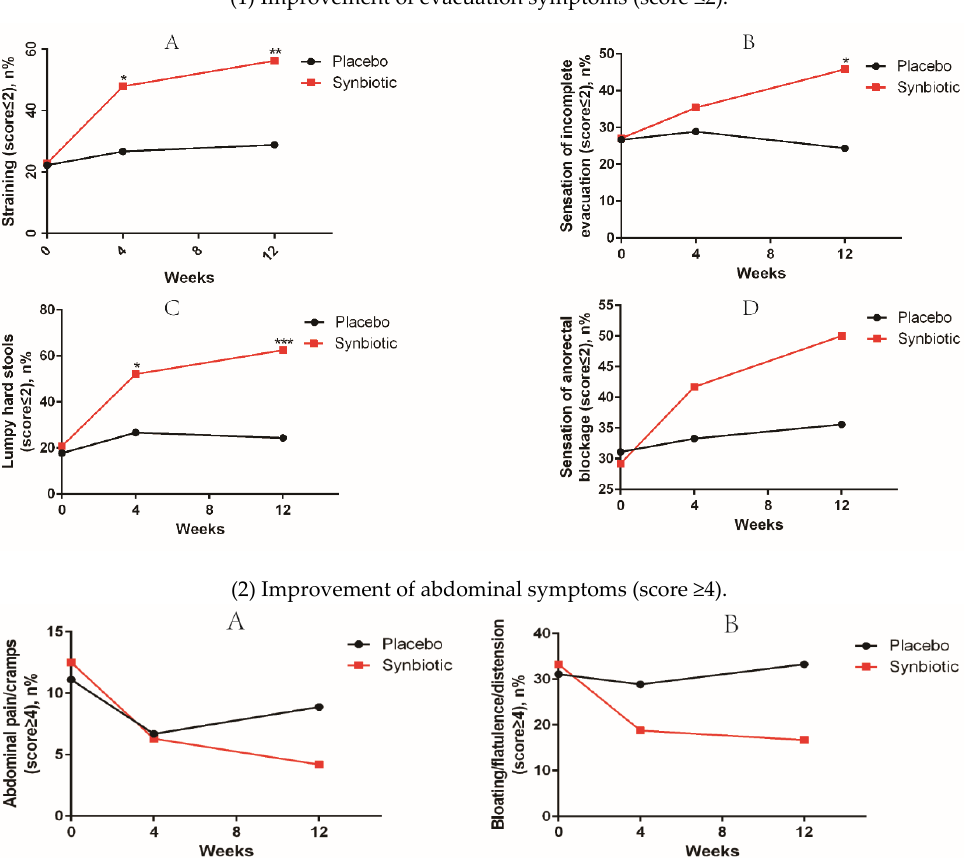
Figure 2. Improvement of constipation-ralated symptoms in the treatment vs. placebo groups. 5-point ordinal scale, 1 indicates none, 2 mild, 3 moderate, 4 severe, and 5 very severe. * p value < 0.05; ** p value < 0.01; *** p value < 0.001. (1) Improvement of evacuation symptoms in treatment vs. placebo groups at baseline, week 4, and week 12; (2) Improvement of abdominal symptoms in treatment vs. placebo groups at baseline, week 4, and week 12.